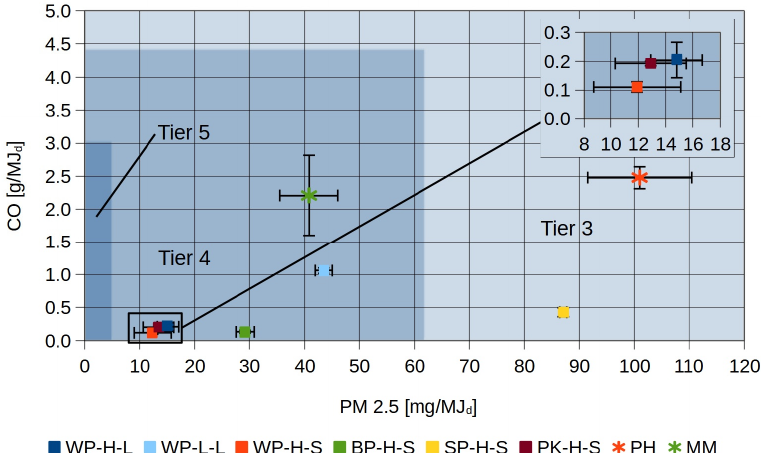
Figure 5. Emissions of the Apeli stove in comparison with the Philips HD4012 [10] and Mimi Moto [10] stoves at high power output. Confidence intervals (90%), as specified in ISO 19867-1 [16], using pooled standard deviations are represented by the error bars.